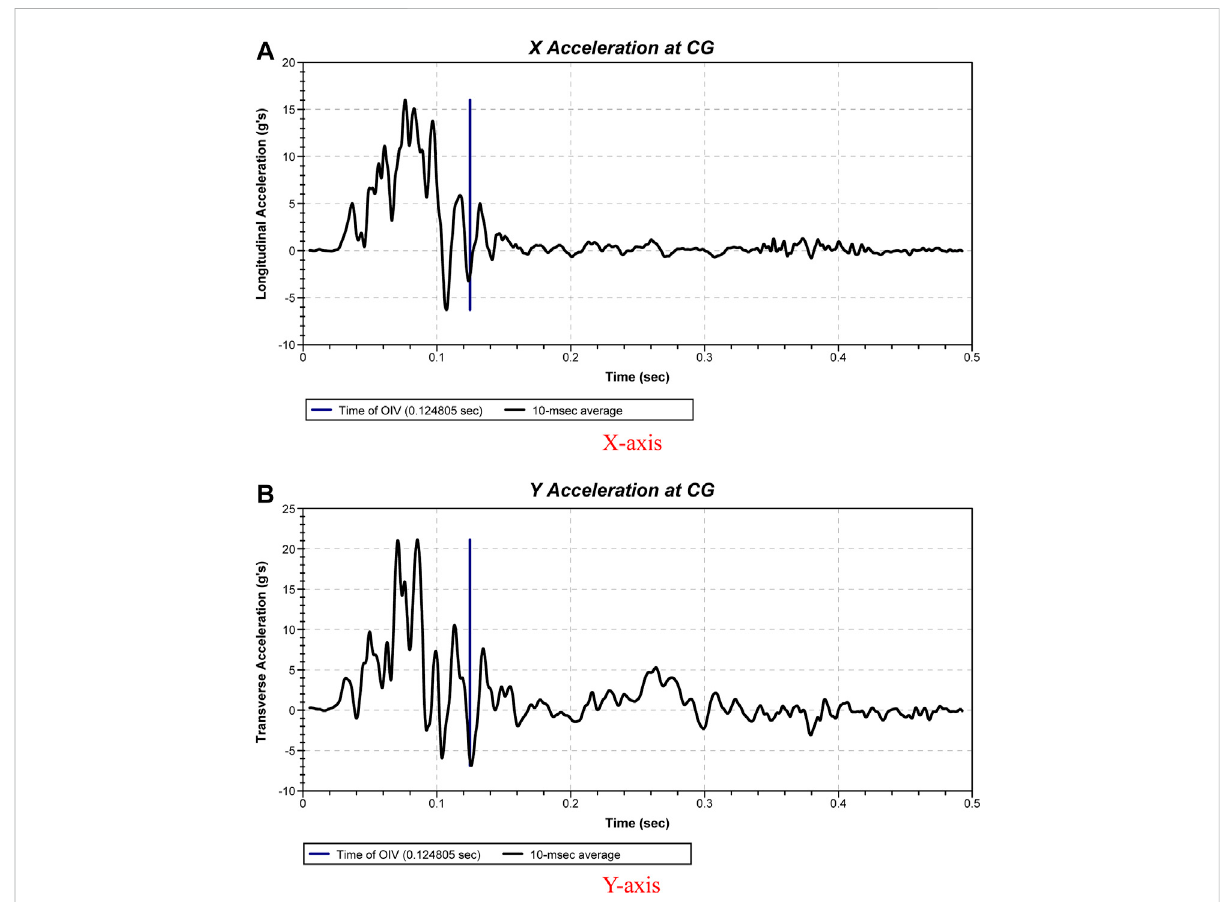
FIGURE 7 Time history curve of the Y-axis and X-axis accelerations at CG of the car. (A) X-axis. (B) Y-axis.